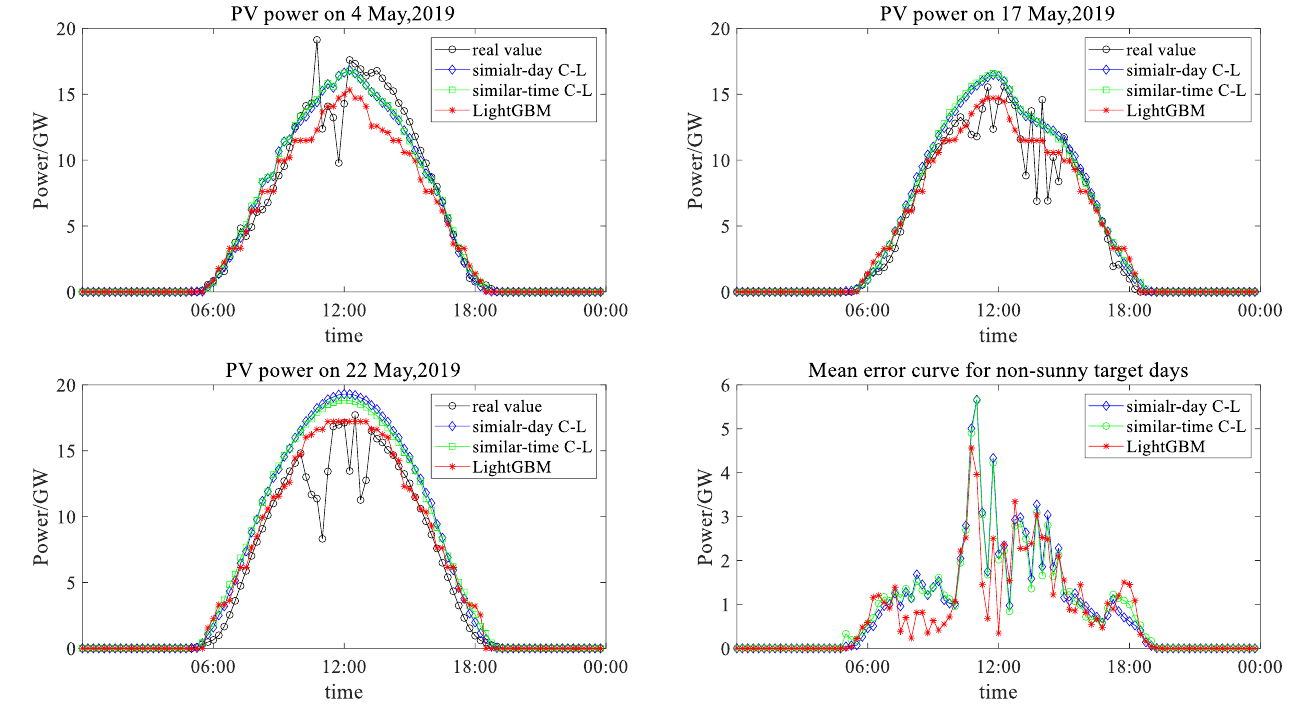
Figure 10. Predicted power and mean error curves for sunny target days.